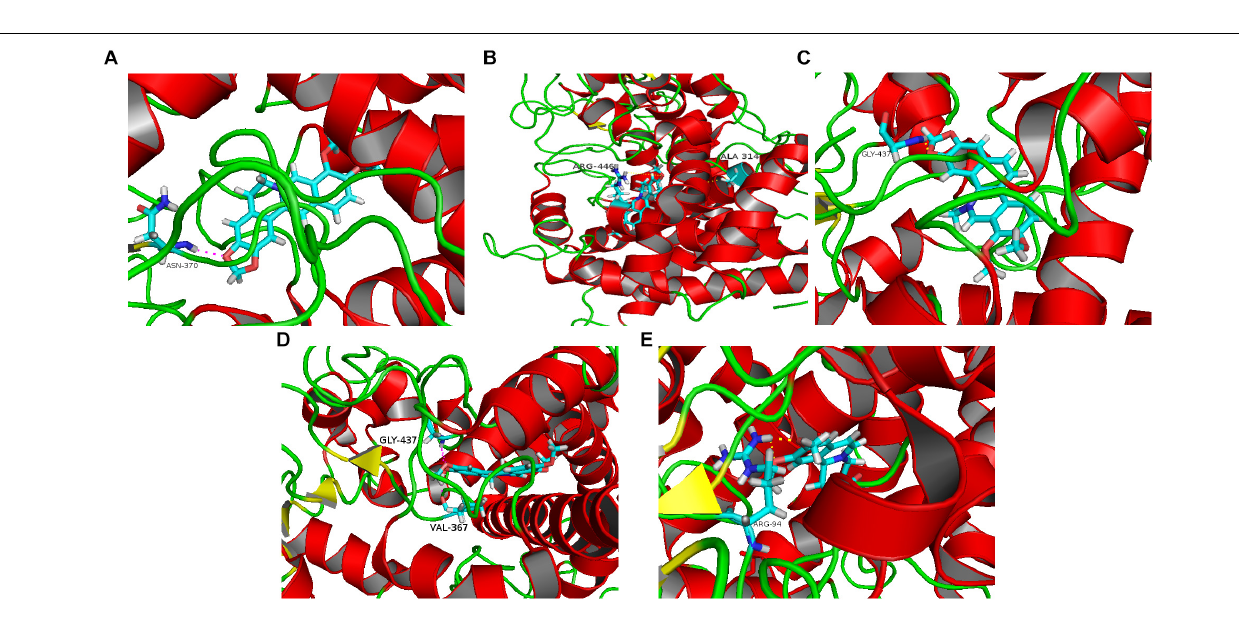
Frontiers in Microbiology |